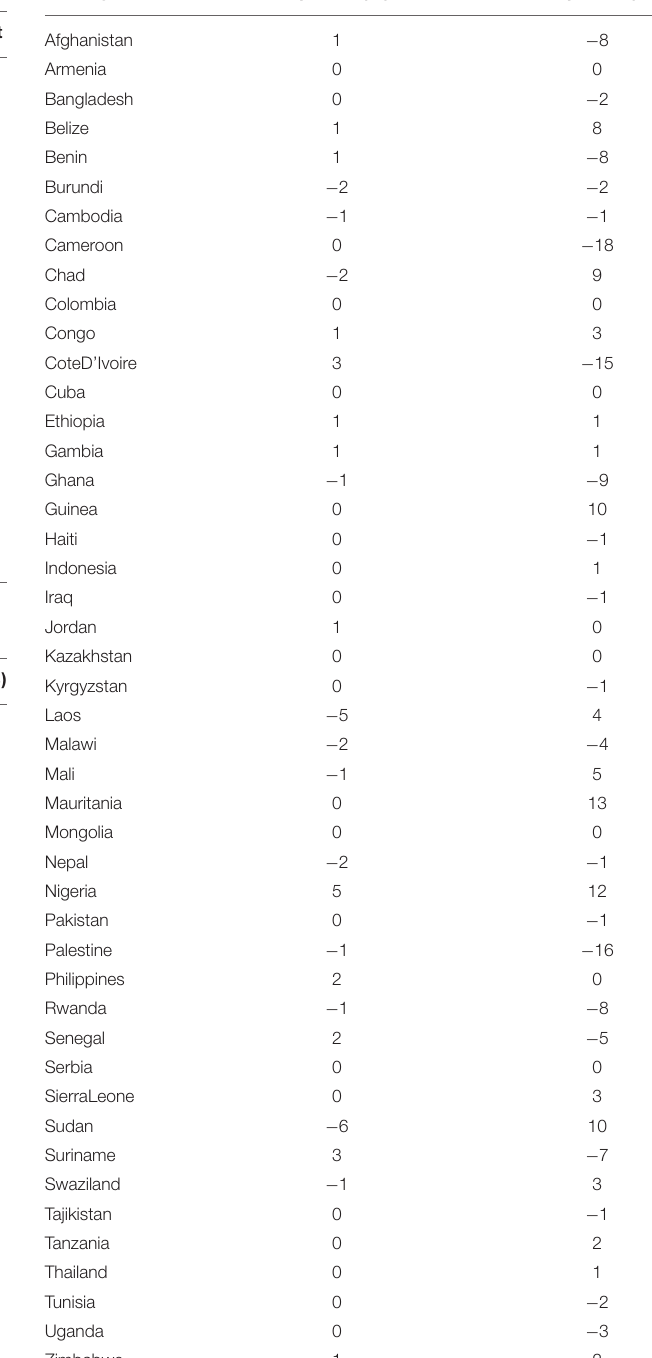
TABLE 4 | Change in private sector percentage of service provision, most recent TABLE 2 | Proportion of care provided by private sector medical providers—top 3 two surveys. countries per region. Country Inpatient Private as a percent of all care Region Country Total Inpatient Outpatient